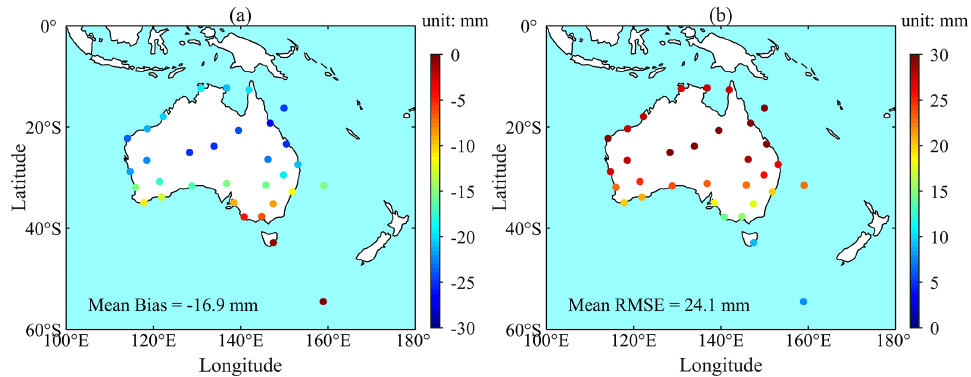
Figure 10. Bias (a) and RMSE (b) between ZHD-ERA5 and ZHD-RS during the 19-year period of 2000–2019 at each of the 32 radiosonde stations located in Australia.